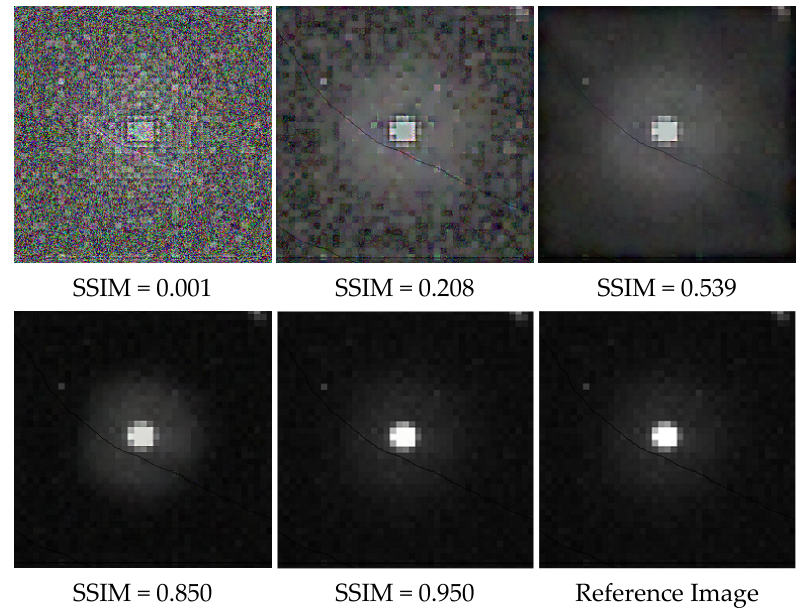
Figure 2. Images of different SSIM values.